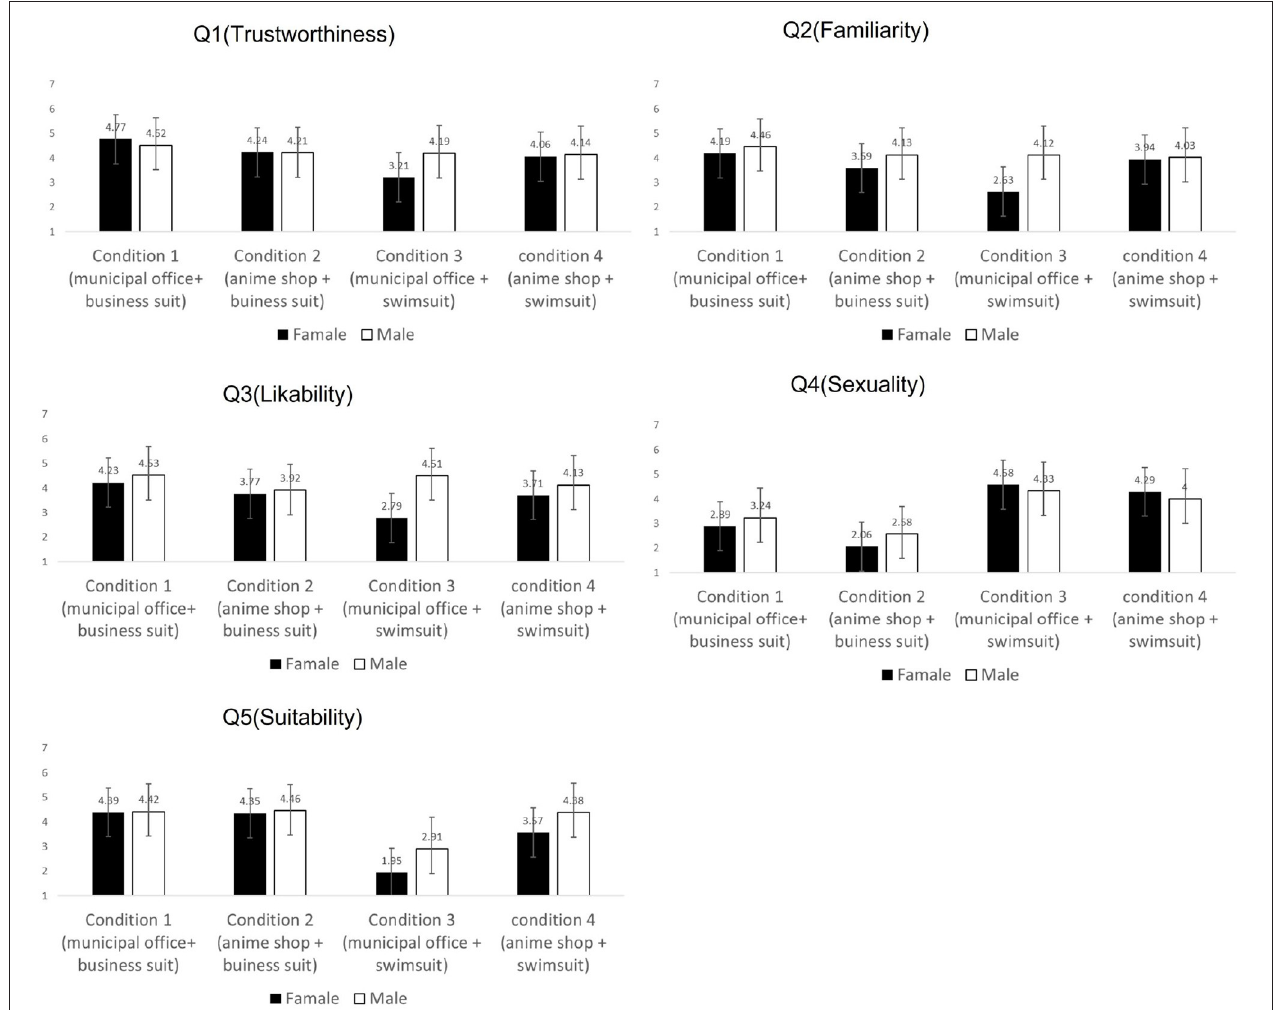
FIGURE 3 | Graphs showing averages for each question observed in the